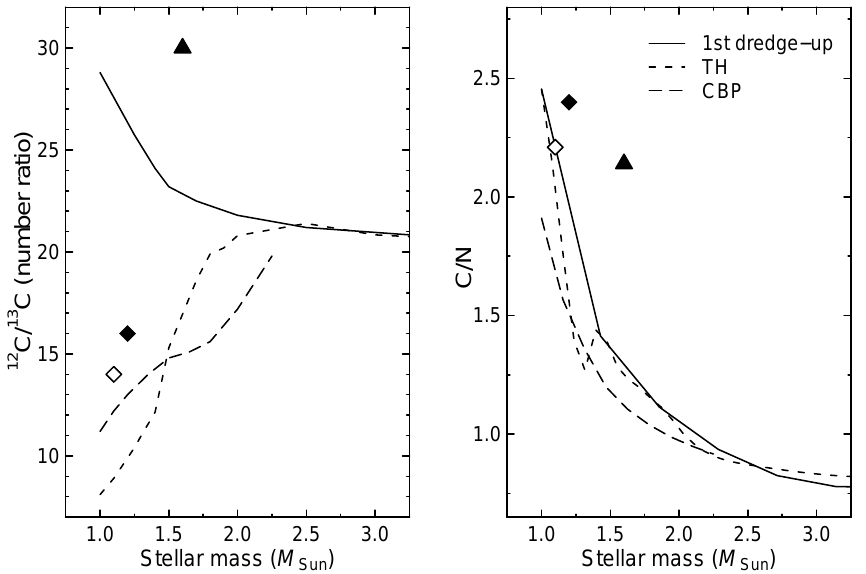
Fig. 9. Comparisons of C/N and 12 C/ 13 C ratios in 33 Psc (filled triangles), (cid:21) And (open diamonds, Paper I) and 29 Dra (filled diamonds, Paper II) with the theoretical predictions explained in the